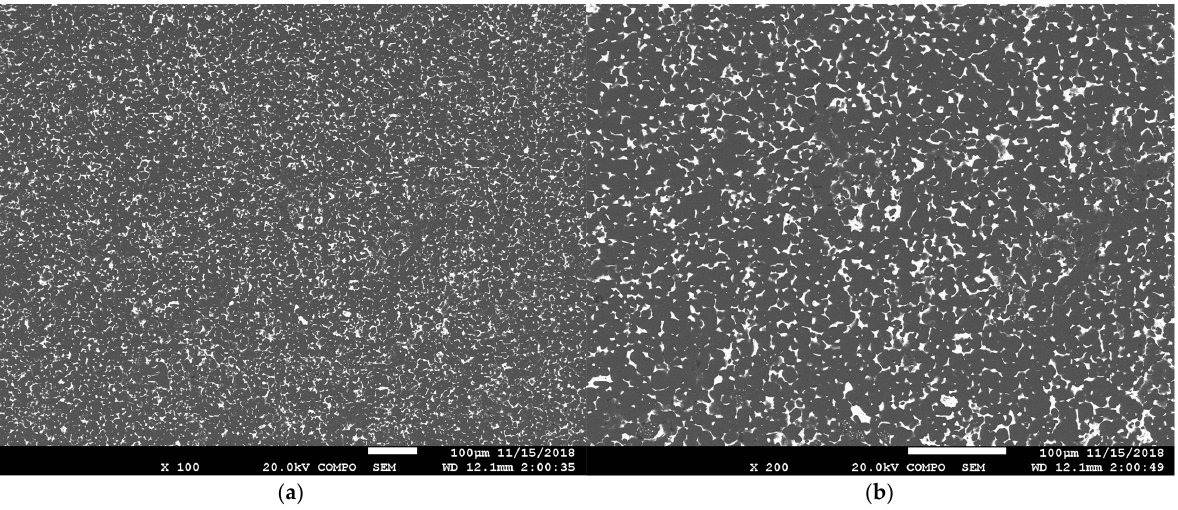
Figure 18. SEM images of a spray-formed ingot after densification. ( a ) magnified 100 times, ( b ) magnified 200 times.